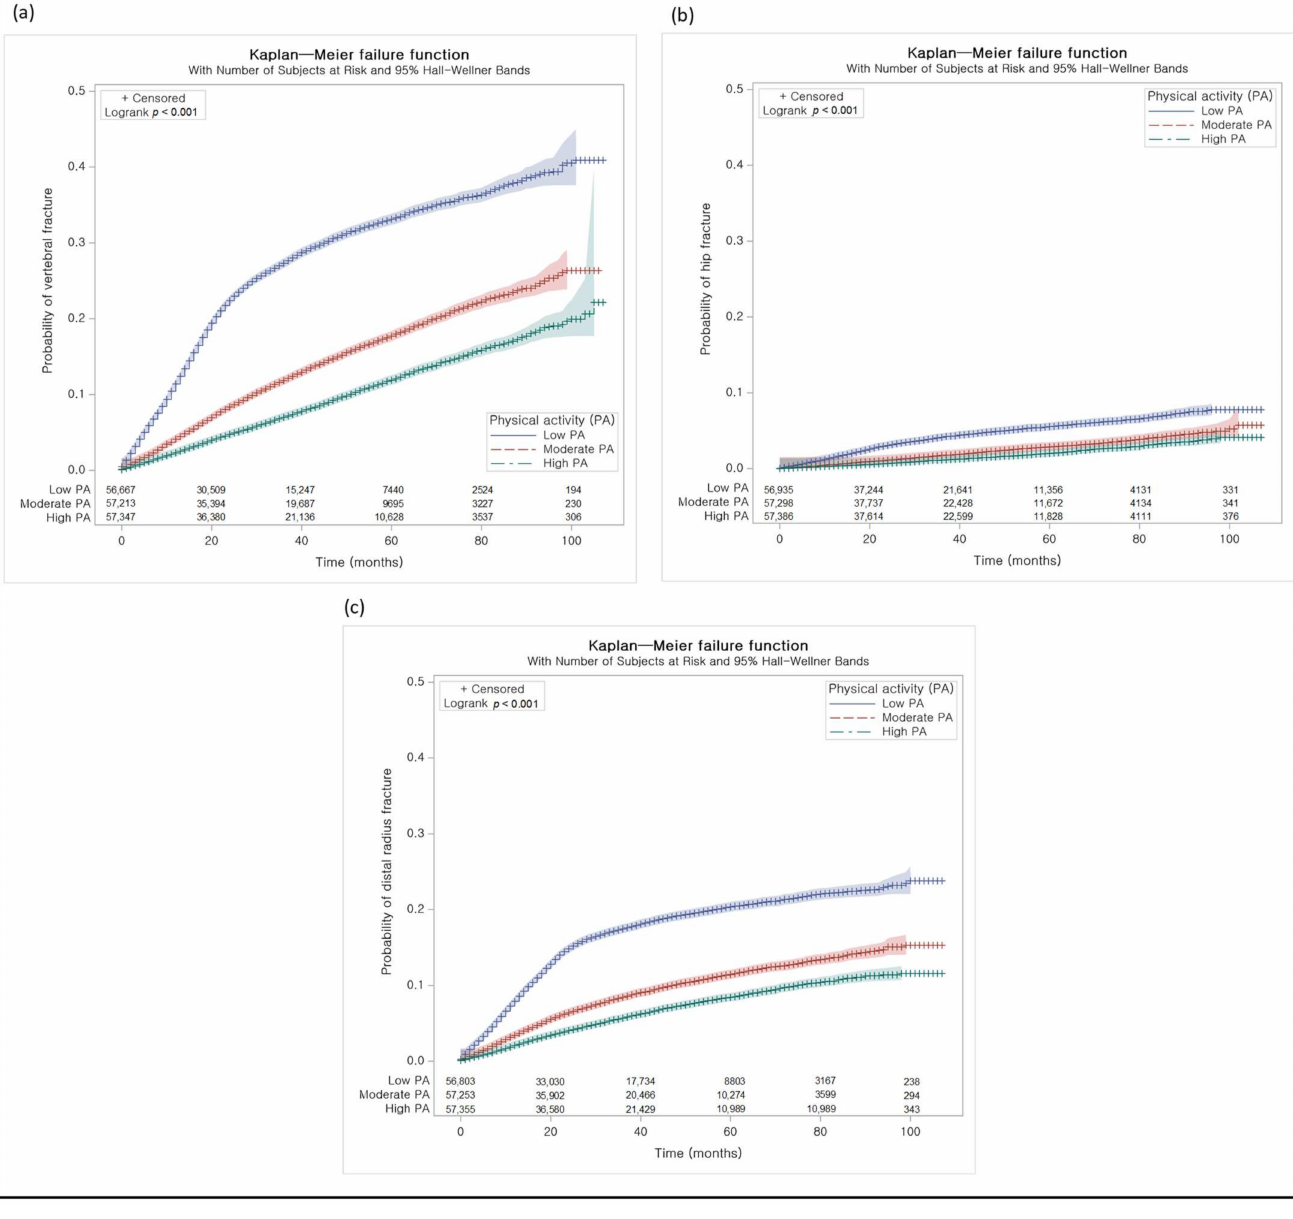
Figure 2. Kaplan–Meier failure analyses. ( a ) The cumulative proportion of vertebral fracture was low in the order of ‘high PA’, ‘moderate PA’, and ‘low PA’. ( b ) The cumulative proportion of hip fracture was low in the order of ‘high PA’, ‘moderate PA’, and ‘low PA’. ( c ) The cumulative proportion of distal radius fracture was low in the order of ‘high PA’, ‘moderate PA’, and ‘low